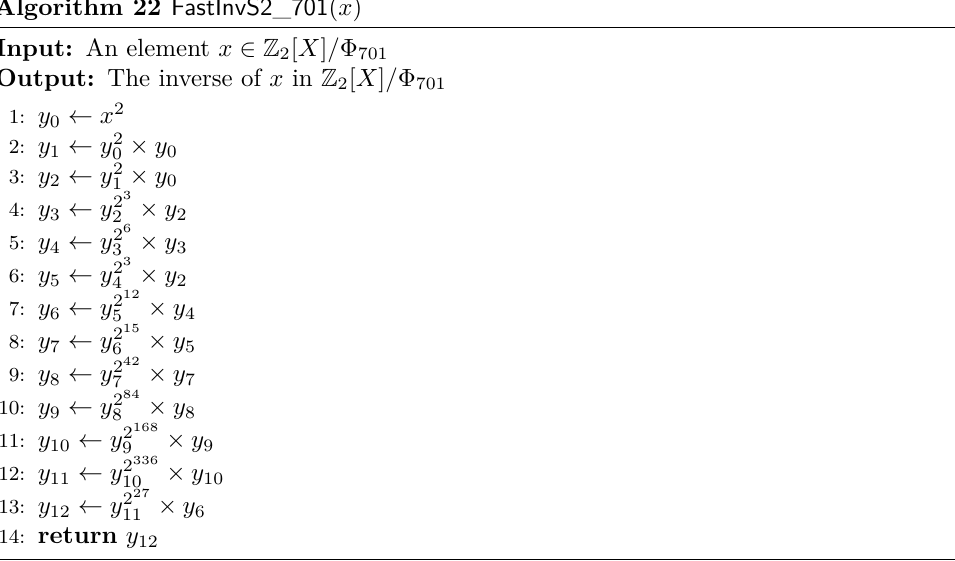
Algorithm 22 FastInvS2 _ 701 ( x